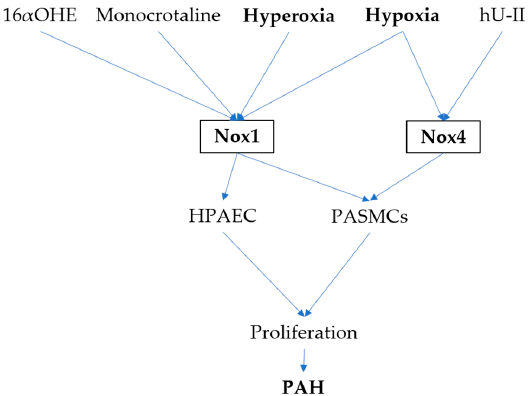
Figure 1. Role of Nox in pulmonary artery hypertension (PAH). Nox1 and Nox4 expressed in human pulmonary artery endothelial cells (HPAECs) and pulmonary artery smooth muscle cells (PASMCs)